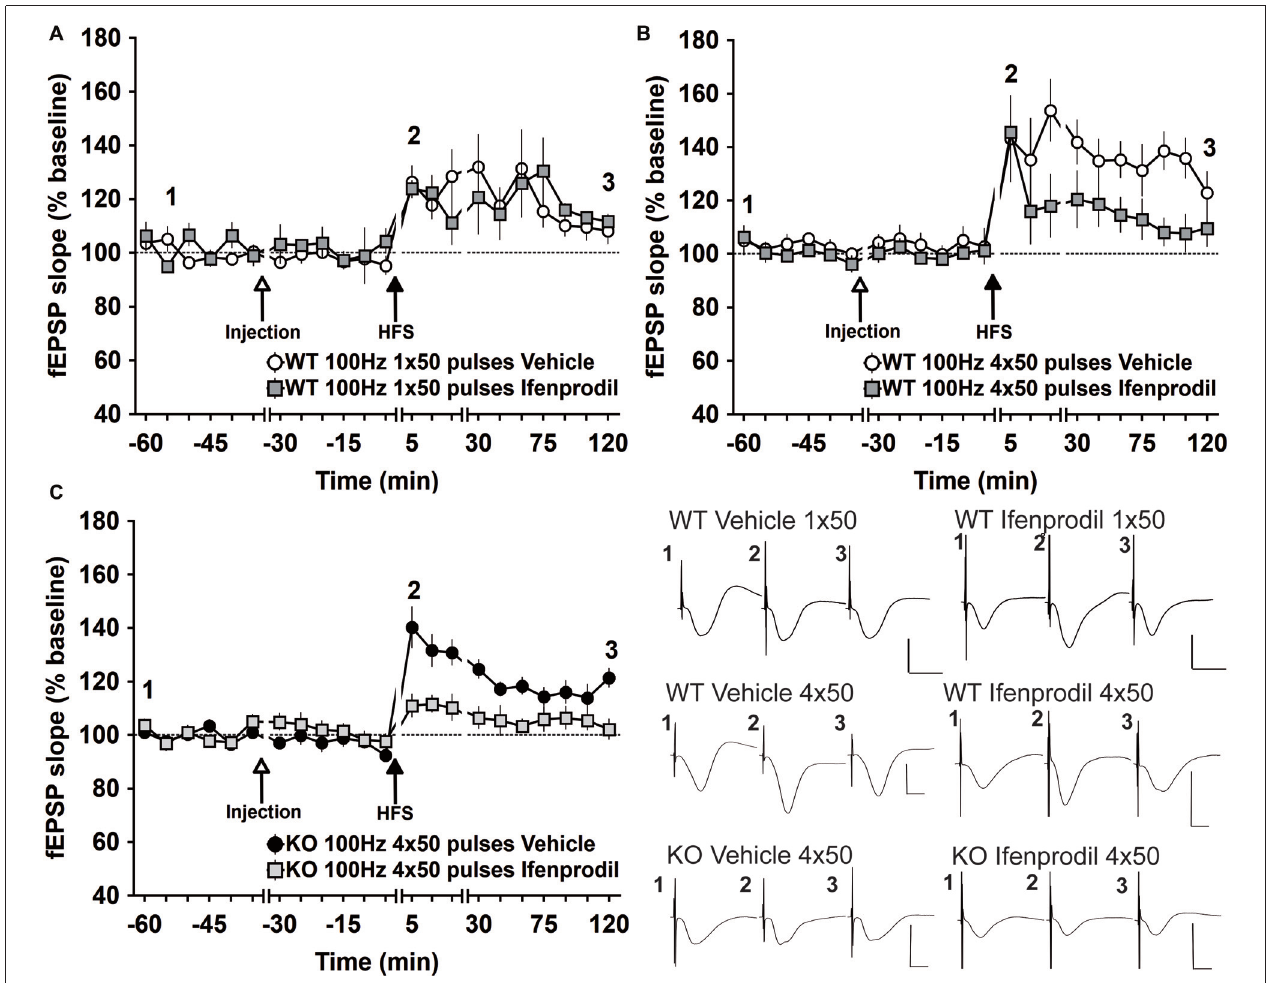
FIGURE 3 | Antagonism of GluN2B in freely behaving WT mice prevents LTP (2 h) but not E-LTP ( < 1 h), antagonism of GluN2B in GluN2A-KO mice prevents LTP (>2 h). (A) Specific antagonism of GluN2B by Ifenprodil has no effect on E-LTP induced in WT mice. (B) Ifenprodil elicits no effect on E-LTP induced in WT, whereas LTP (2 h) is prevented. (C) Ifenprodil prevents E-LTP and LTP in GluN2A KO mice. Insets: examples of fEPSPs evoked at the time-points indicated by the numbers. Horizontal scale bar: 10 ms, vertical scale bar: 2